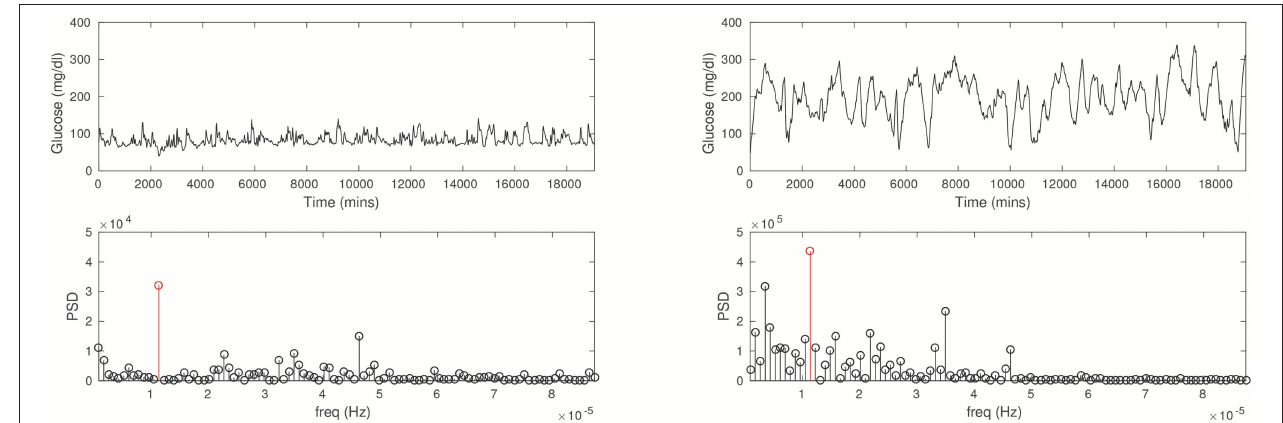
FIGURE 1 | The CGM time series recorded for a healthy, non-diabetic subject (Left column) and a diabetic patient (Right column). Notice the average glucose is substantially lower in the non-diabetic (about 100 mg/dl) than in the diabetic (about 200 mg/dl). The glucose pulses are of large amplitude in the diabetic, and appear to be wider as well. Power spectral density (PSD; second row) shows a prominent peak at a period of about 24 h in either case (red stems), although the frequency profiles are not